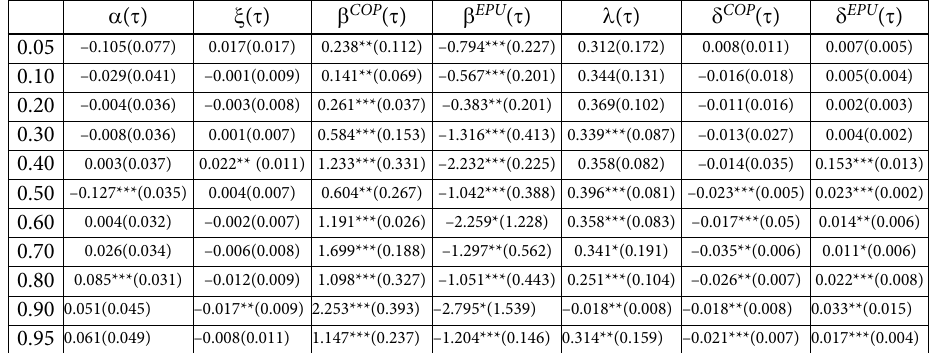
Table 3. Results of quantile autoregressive distributed lag (QARDL) for GBI a ( t